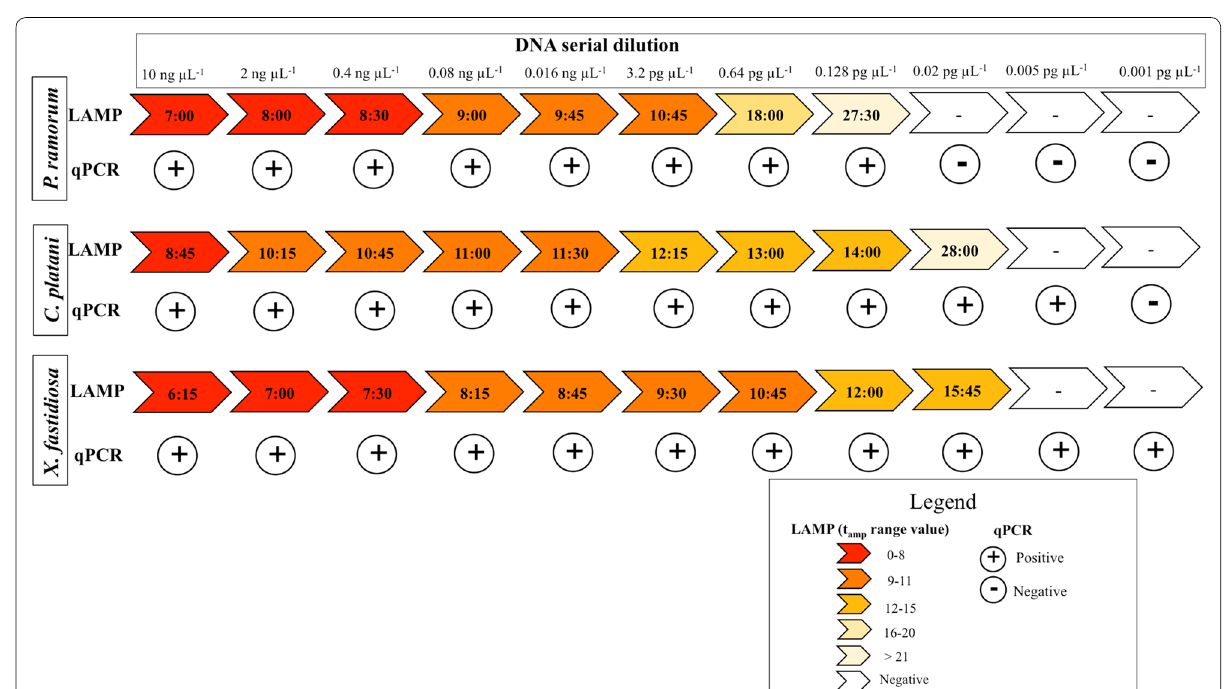
Fig. 2 Sensitivity results obtained by testing both on LAMP and qPCR 11-fold 1:5 serial dilution (ranged from 10 ng μL − 1 to 0.001 pg μL − 1 ) of each standard DNA template ( X. fastidiosa —Co.Di.Ro strain; C. platani —isolate Cp24; P. ramorum - isolate Pram). LAMP results are inserted in a scale from positive (red) to negative (white) based on amplification time (t amp ; min:s). Real-time qPCR results are reported as positive (